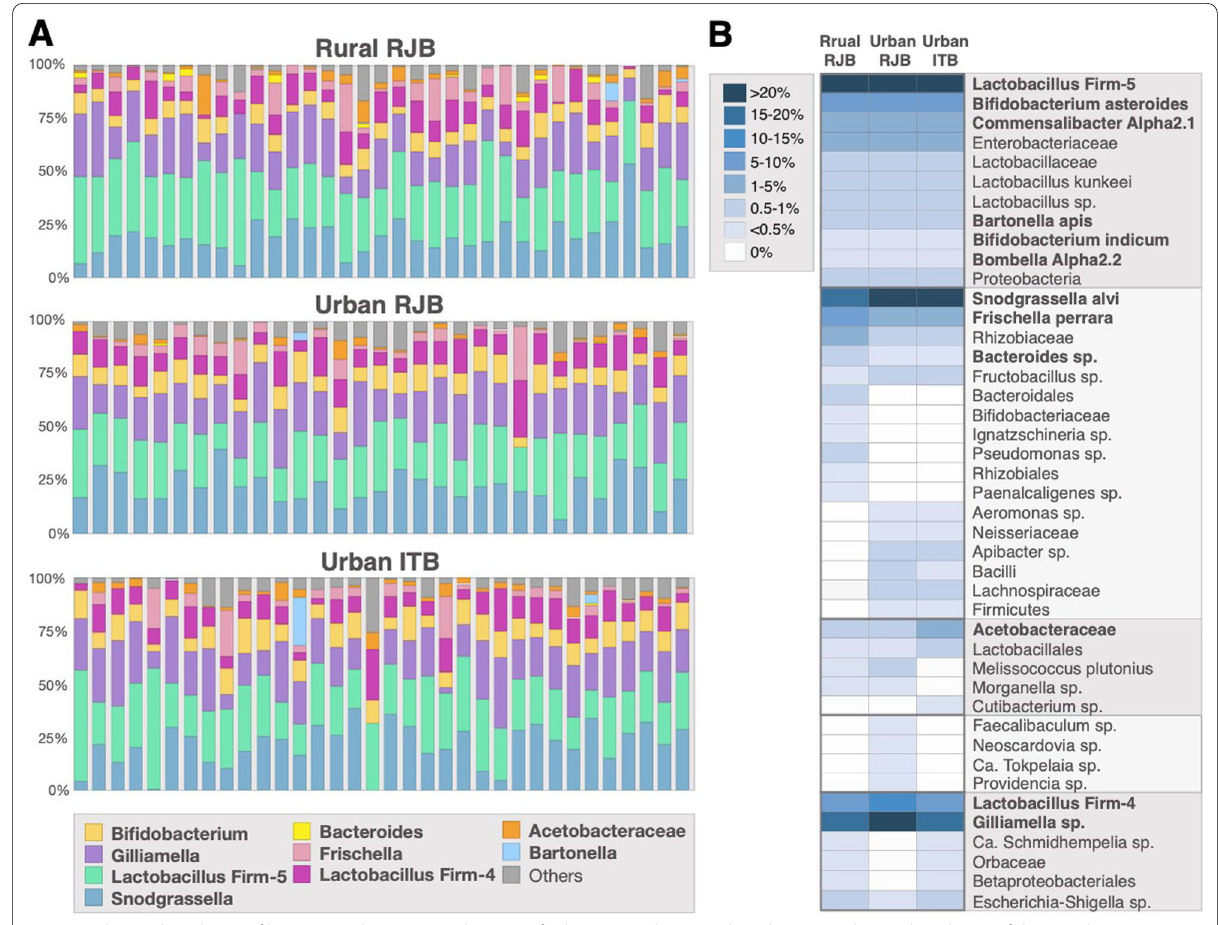
Fig. 3 Relative abundance of bacteria in the gut microbiomes of urban ITB and RJBs and rural RJBs. a Relative abundance of the nine honey bee-associated taxa in each individual. b Heatmap of the average relative abundance of all taxa detected in rural RJBs, and urban RJBs and urban TBs clustered to the highest taxonomic level